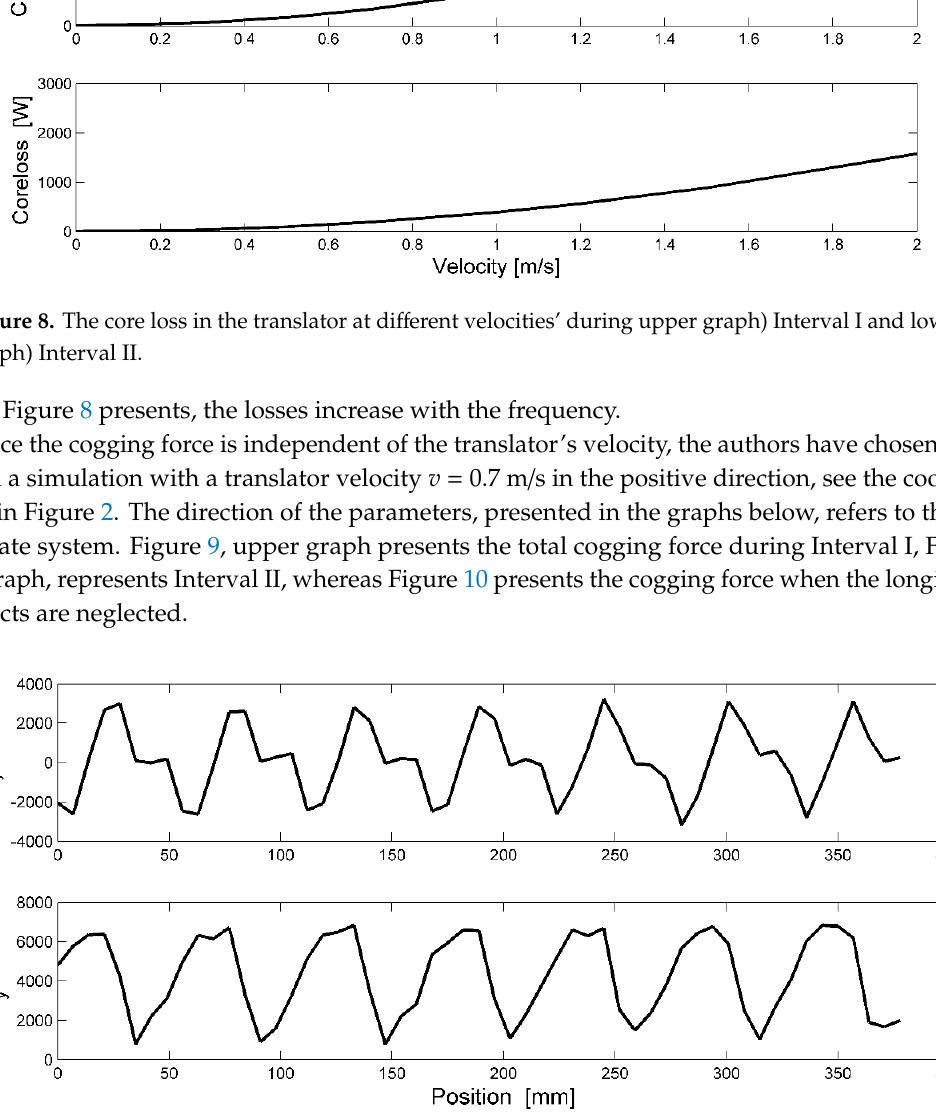
Figure 9. The cogging force changes drastically when the generator’s operation point changes from Interval I to Interval II. The lower graph presents the cogging force both when the translator enters and leaves the stator.